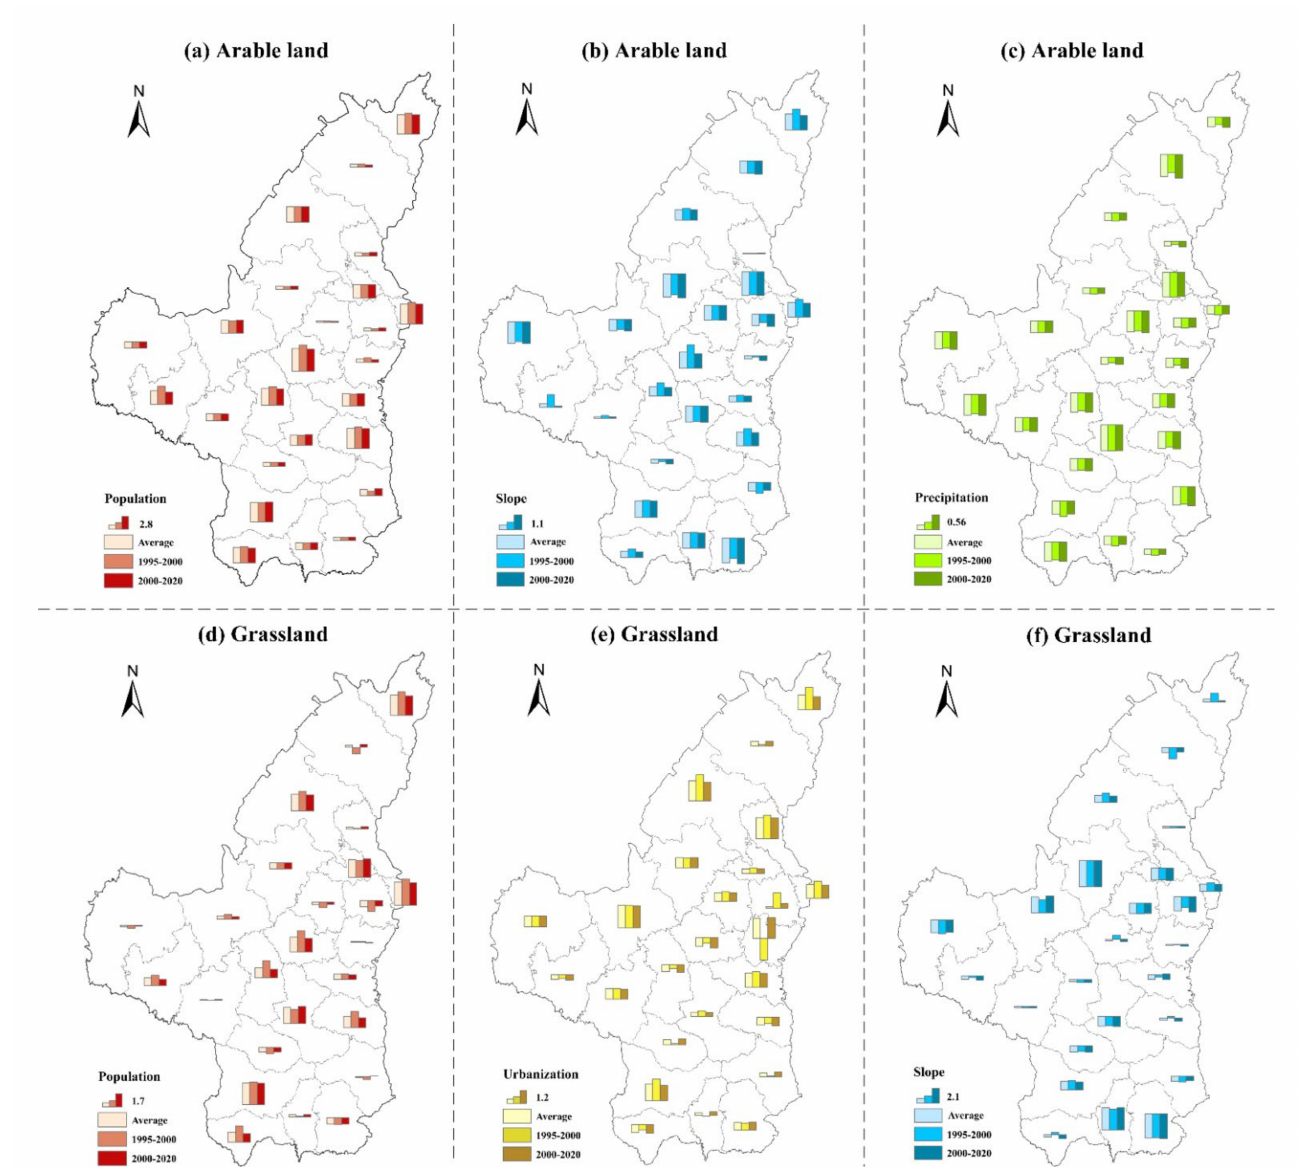
Figure 4. The mean regression coefficients of core factors for arable land and